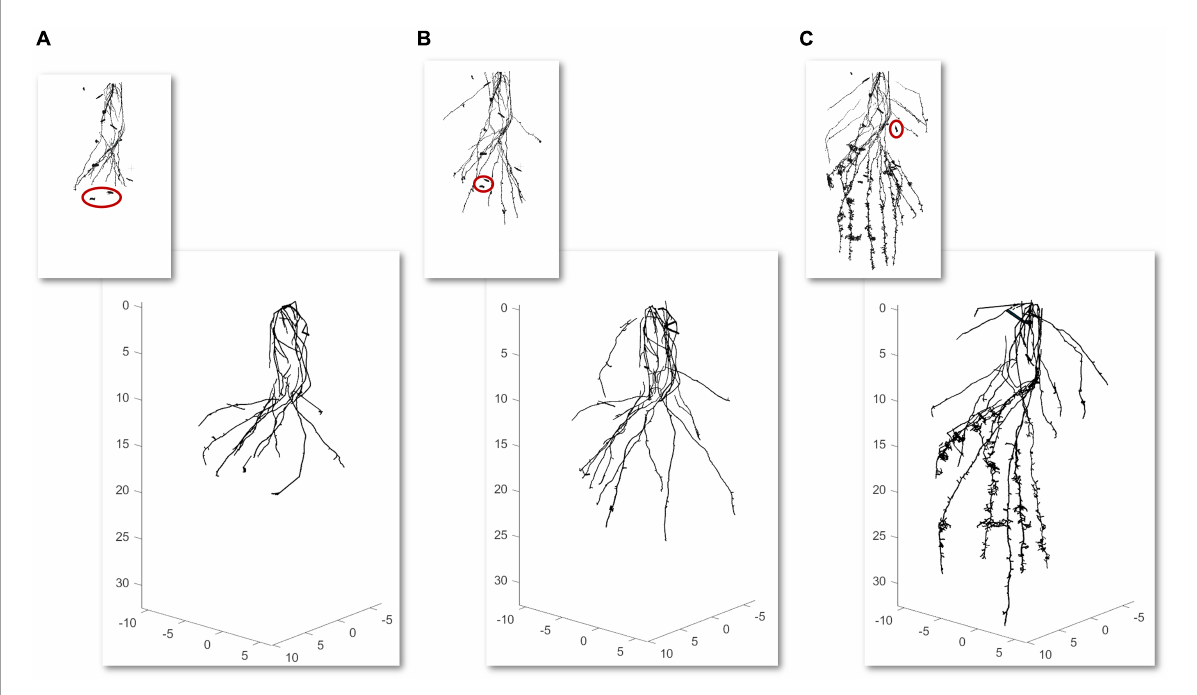
FIGURE4 Time-lapse modeling of 3 weekly computed tomography (CT) scans scale factor (SF of 0.1) from the same root sample (axes in cm) (A–C) with a scan miniature in the upper part. Samples of noise reduction from the scans are marked in red.